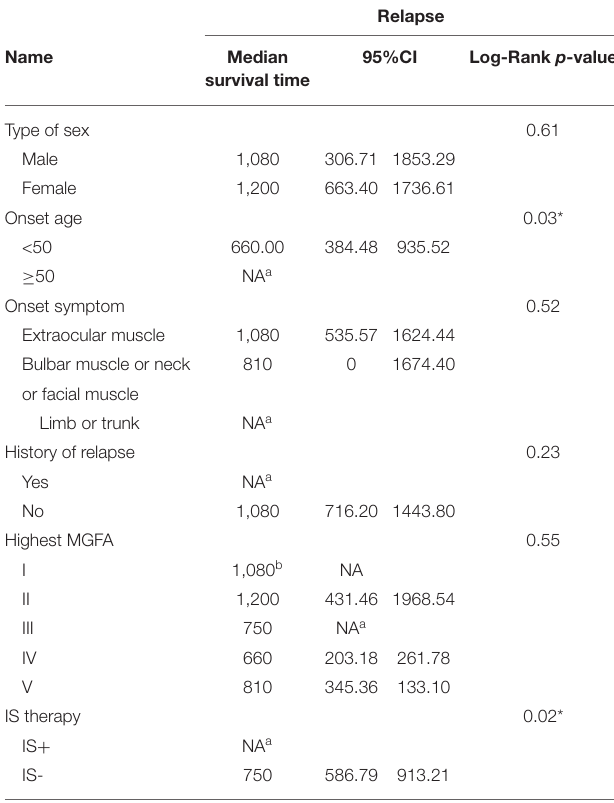
TABLE 2 | Log-Rank test of relapse and demographic